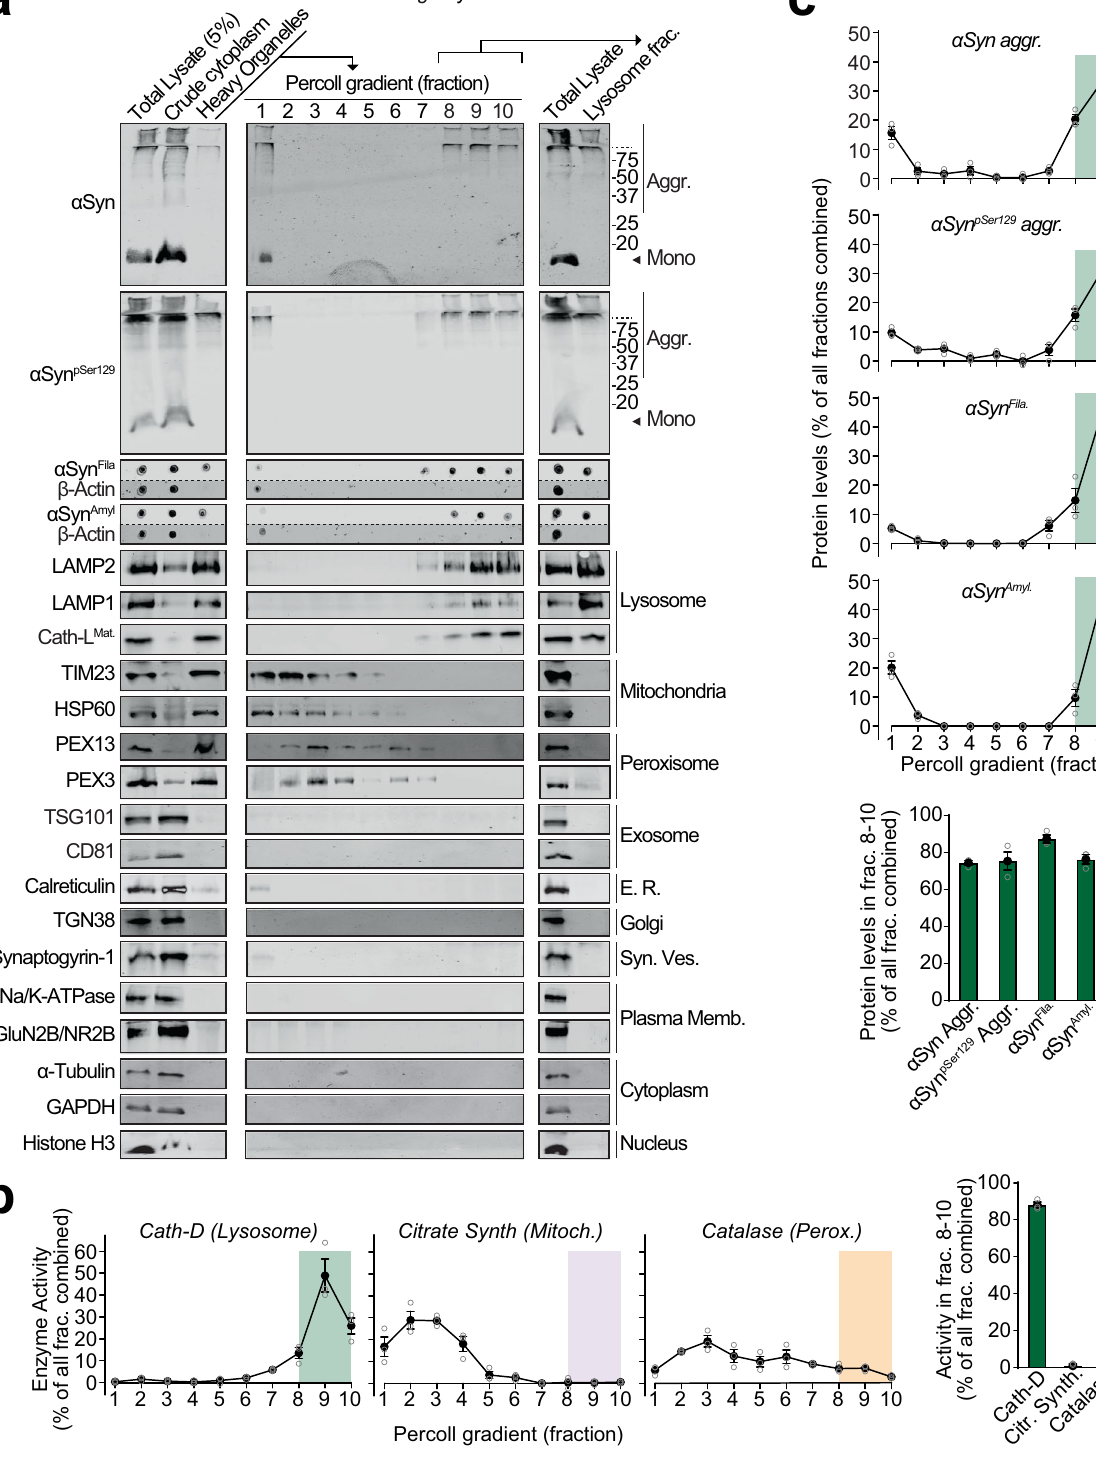
synthase),andperoxisomes(catalase)weremeasured,testingforisolationofintact organelles. Right panel — Summary graph of enzyme activity present in the com- bined “ lysosomal fractions ” (fractions 8 – 10). c Top panels — Levels in each Percoll gradient fraction of pathogenic α Syn species: Aggregated ( α Syn Aggr), aggregates phosphorylated at Ser129 ( α Syn pSer129 Aggr), fi lamentous ( α Syn Fila ), and amyloid- type( α Syn Amyl ).Bottompanel — Summarygraphofthese α Synspeciespresentinthe combined “ lysosomal fractions ” (fractions 8 – 10). ( n =3). All data are shown as means±SEM, where “ n ” represents mouse